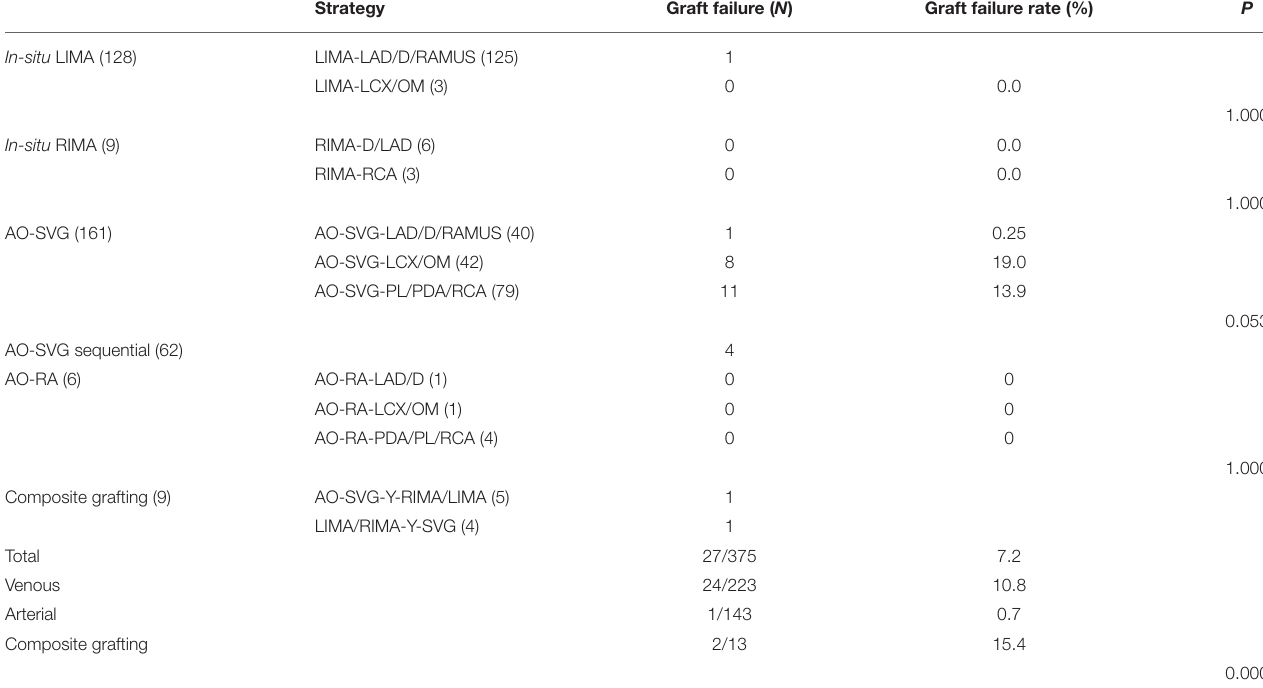
TABLE 3 | Details of CTA examination at approximately 1 year after CABG.